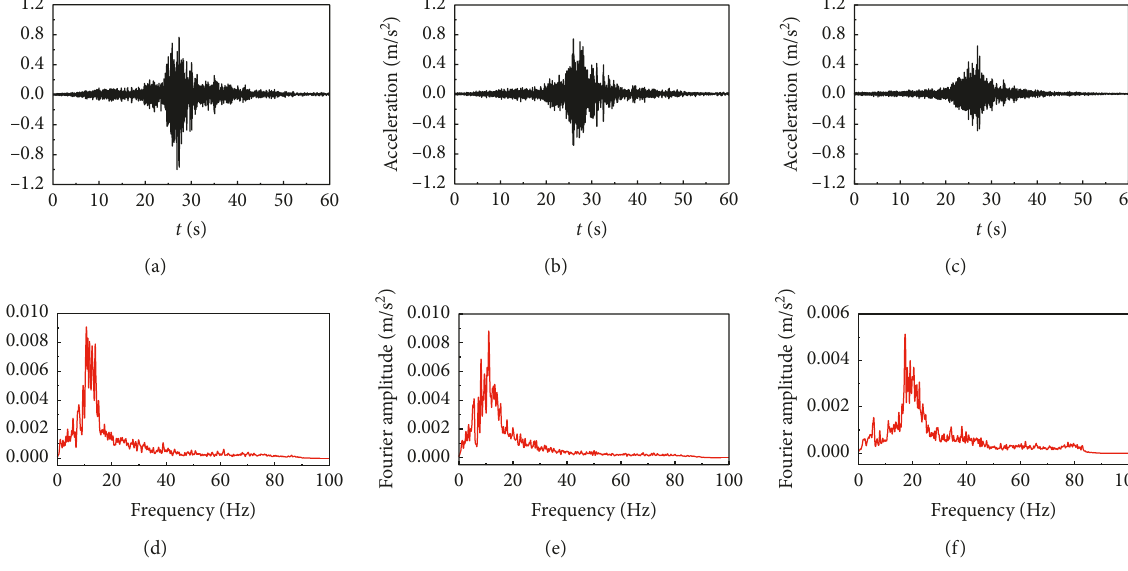
Figure 6: Details of the 311 seismic motion. (a) Time history curve in x direction; (b) time history curve in y direction; (c) time history curve in z direction; (d) Fourier spectra in x direction; (e) Fourier spectra in y direction; (f) Fourier spectra in z